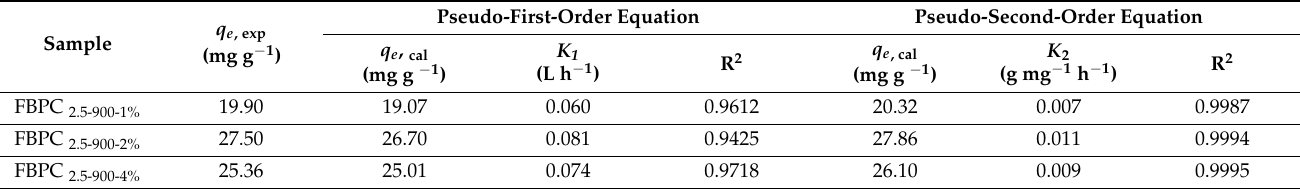
Figure 5. Effect of the initial pH value on Cu(II) adsorption on ( a ) FBPC 2.5-900-1% , ( b ) FBPC 2.5-900-2% , ( c ) FBPC 2.5-900-4% . Adsor- bent dose = 0.35 g L − 1 ; shaking time = 120 min; temperature = 298 K; pH = 2–5; shaking speed = 300 rpm; initial Cu(II) concentration = 100 mg L − 1 . Table 2. Isotherm adsorption parameters for the process of Cu(II) removal by the FBPC samples. Sample